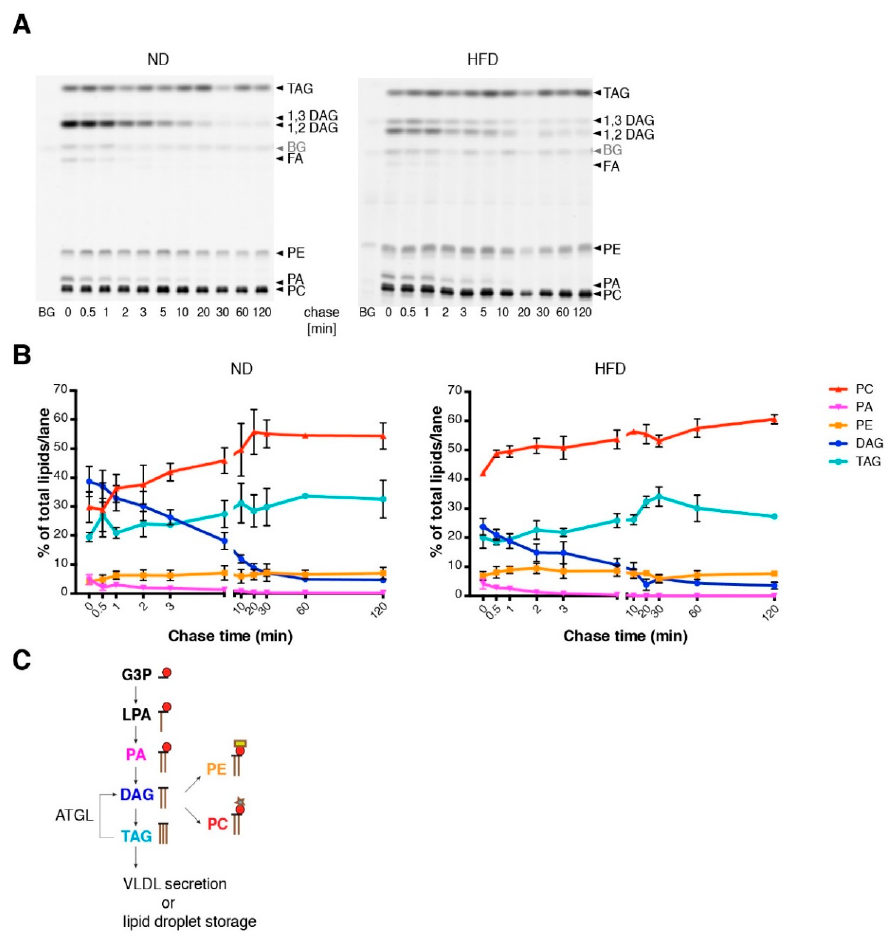
Figure 2. Lipid metabolism in isolated hepatocytes of ND and HFD mice. ( A ) Hepatocytes from ND or HFD mice were cultured for 2 h prior to pulse-chase experiments. After pulse incubation (2